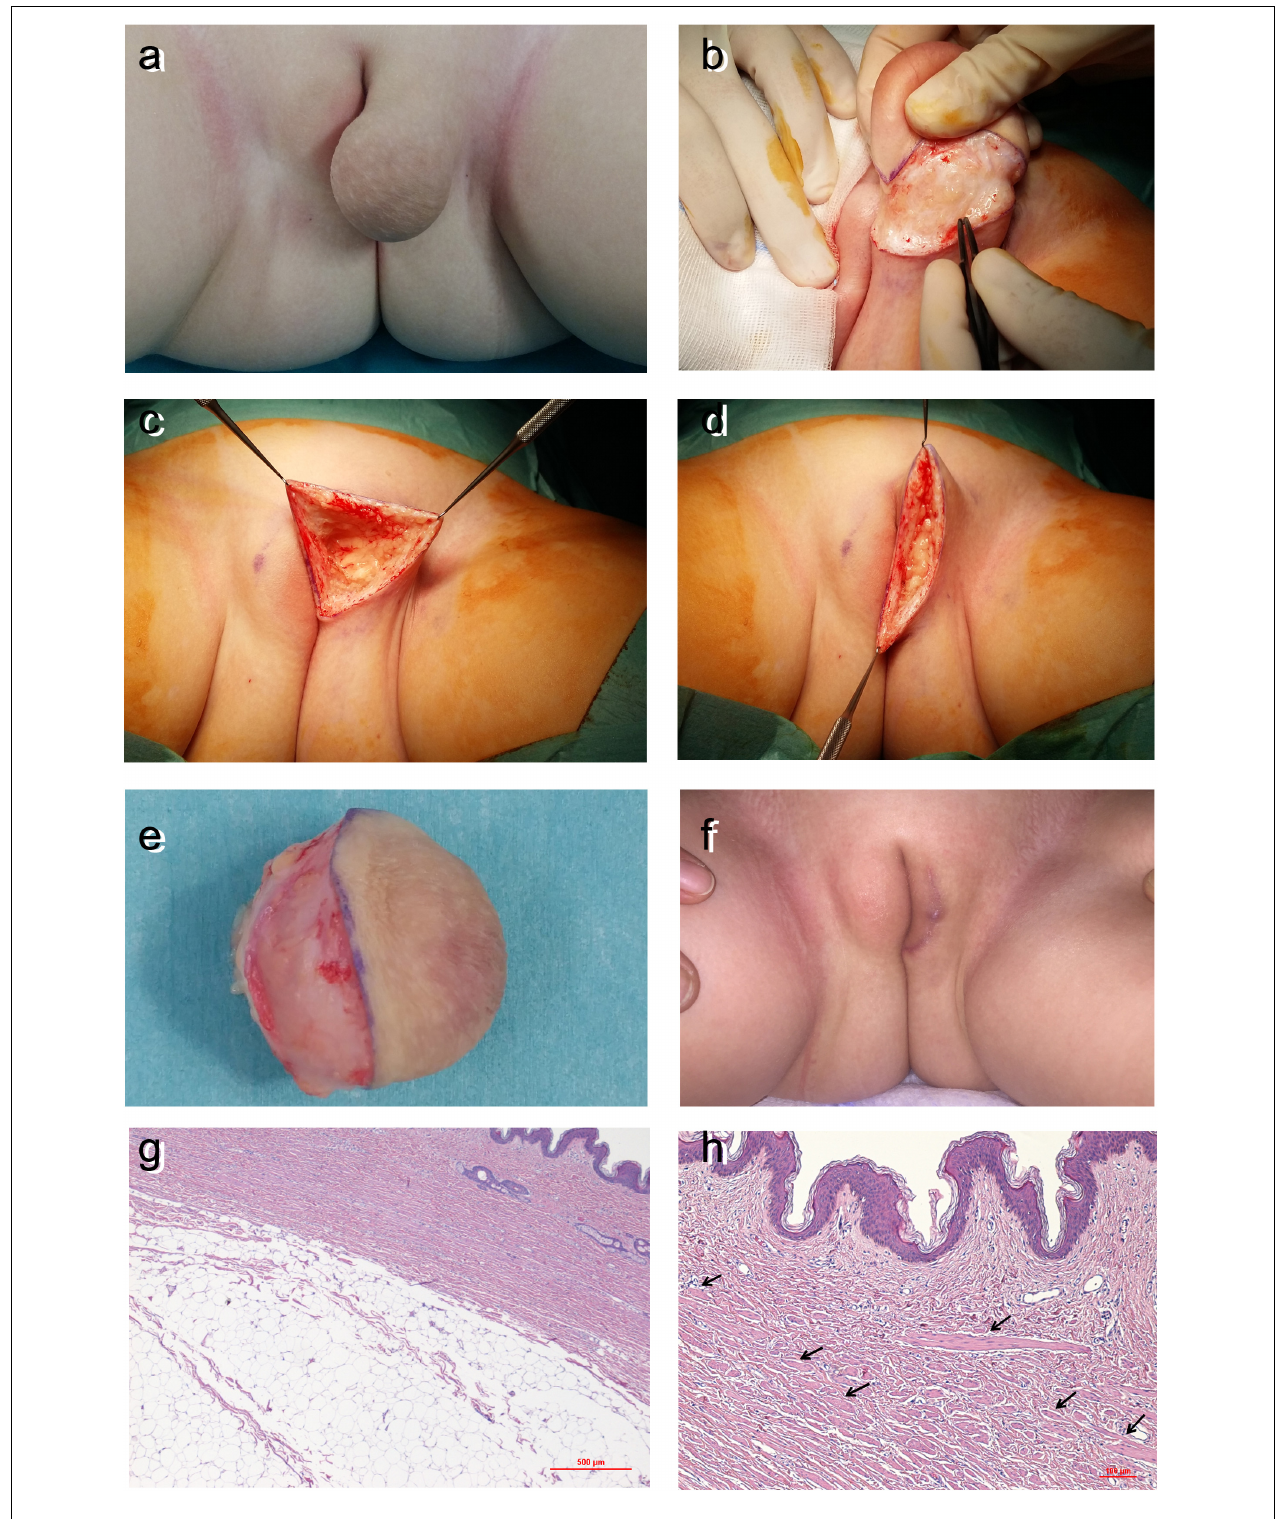
FIGURE 3 | Case 3. (a) Soft and spherical mass arising from the central and caudal aspects of the left labium major with wrinkled unpigmented skin above. Surgery: (b) excision of the mass and (c) the labium major after mass excision. (d) Suture edges conform to continuous resorbable stitches. (e) Surgical specimen. (f) One-month follow-up. (g,h) Histological examination: abundant mature adipose fat cells both in the deep dermis and hypodermis and smooth muscle bundles in the dermis (arrows).